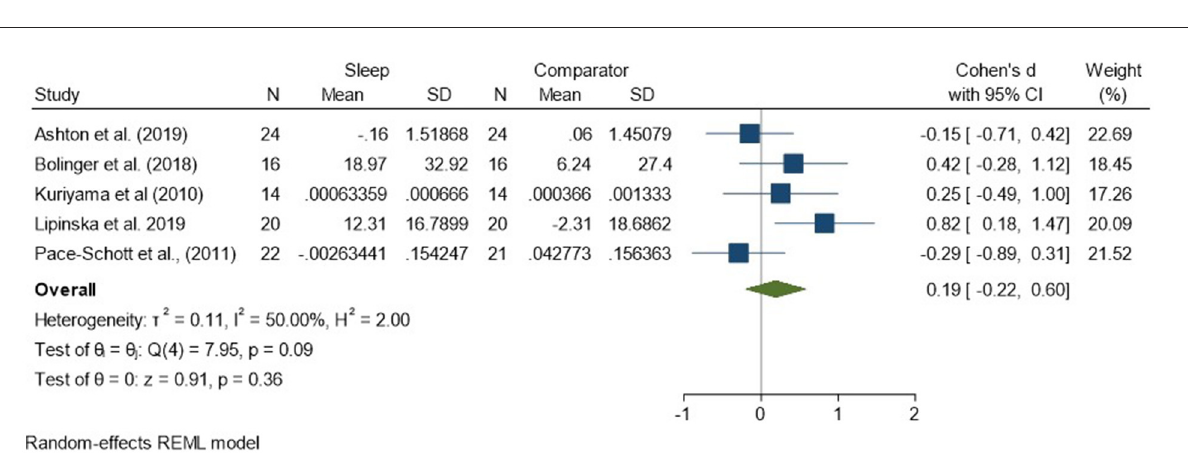
FIGURE5 Meta-analysis II: Physiological outcomes in response to neutral stimuli – changes across a period of sleep compared to across a period of waking ( K = 5, N = 155).